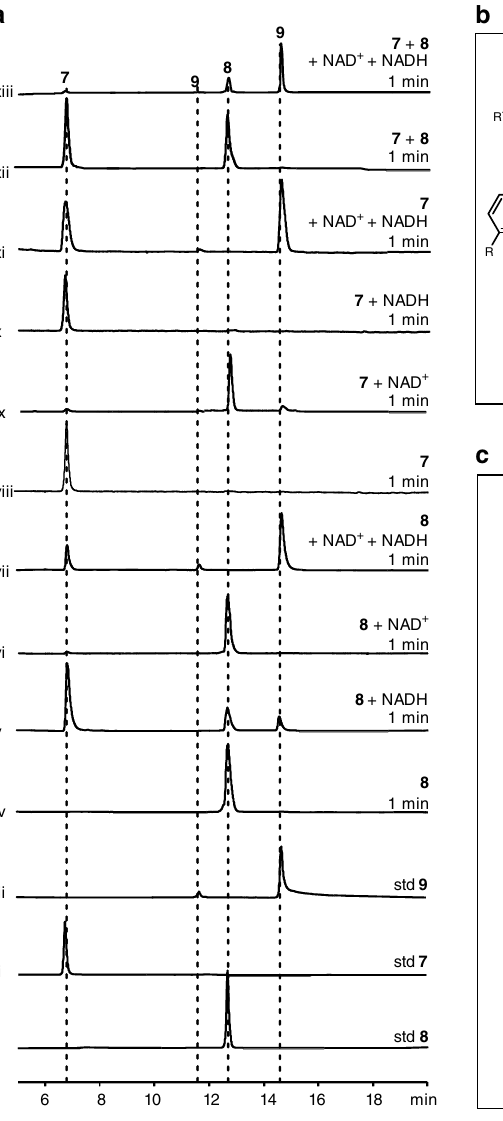
Fig. 3 Biosynthetic pathway of azoxy bond. a HPLC analysis of in vitro non-enzymatic reactions at 370 nm. Reactions were performed in 20 mM HEPES buffer (pH 7). (i) Standard 8 ; (ii) standard 7 ; (iii) standard 9 ; (iv) 8 in buffer for 1 min; (v) 8 with 10 eq NADH in buffer for 1 min; (vi) 8 with 10 eq NAD + in buffer for 1 min; (vii) 8 with 10 eq NAD + and 10 eq NADH in buffer for 1 min; (viii) 7 in buffer for 1 min; (ix) 7 with 10 eq NAD + in buffer for 1 min; (x) 7 with 10 eq NADH in buffer for 1 min; (xi) 7 with 10 eq NAD + and 10 eq NADH in buffer for 1 min; (xii) 7 + 8 in buffer for 1 min; (xiii) 7 + 8 with 10 eq NAD + and 10 eq NADH in buffer for 1 min. b Biosynthetic scheme of 9 from 6 . AzoC enzymatically oxidizes 6 to 8 , and then NAD + /NADH induces non-enzymatic reciprocal transformation between 7 and 8 . 9 is then formed during the redox reaction process. c Proposed radical biosynthetic mechanism of azoxy bond from nitroso